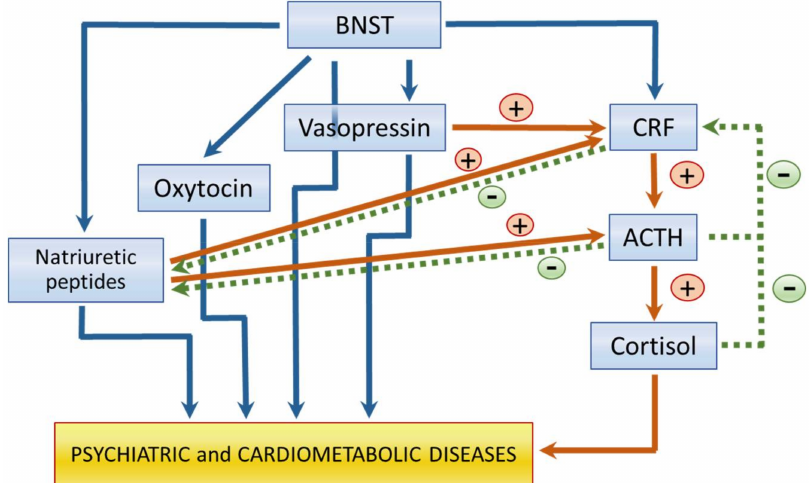
Figure 2. Regulation of neuro- and cardio-active substances by the Bed nucleus of the stria terminalis (BNST) and crosstalk established between them. Blue arrows indicate mediators that are released from the BNST and their relation to psychiatric and cardiometabolic diseases. Brown arrows and + symbol indicate that the pathways increase the mediator release. Green arrows and − symbol indicate that the pathway inhibits the mediator